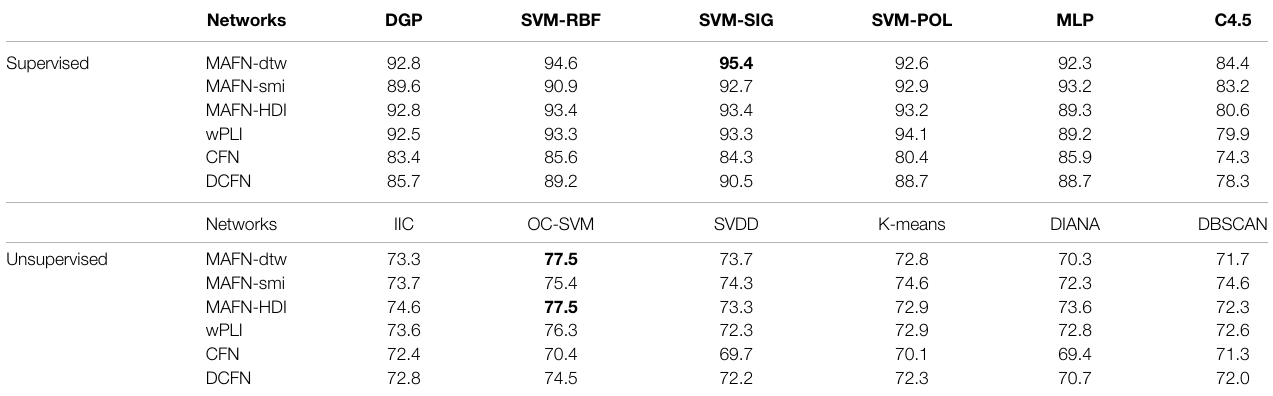
TABLE 3 | Comparison results of MAFNs and other functional methods for epilepsy detection.